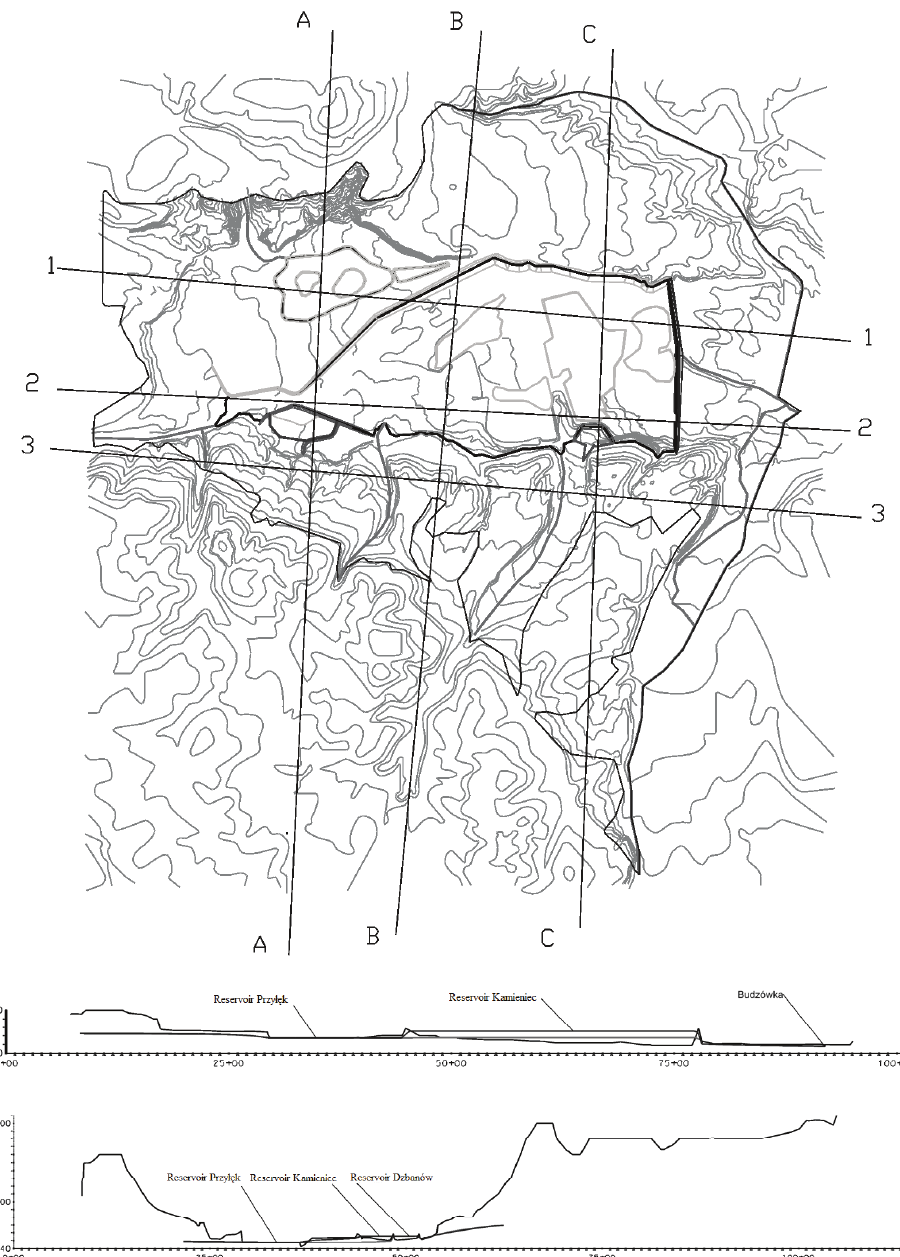
Fig. 15. Examples of cross-sections through the area around the